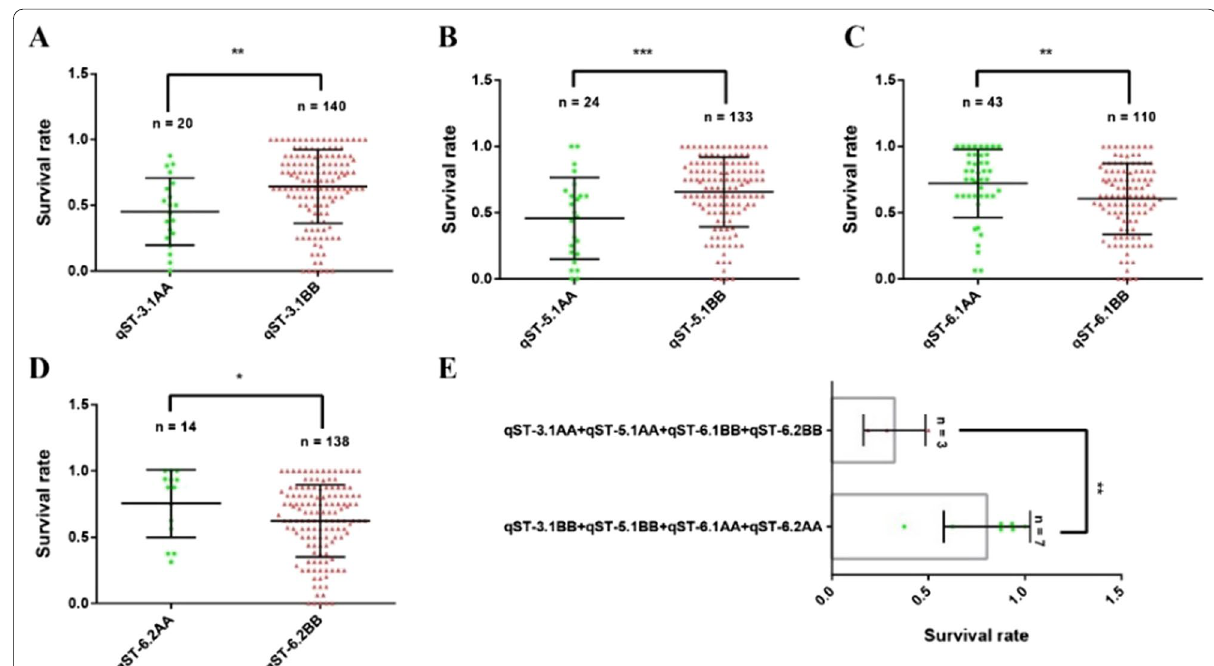
Fig. 4 The survival rate of rice seedlings with different genotyping of RILs. A. qST-3.1 ; B. qST-5.1 ; C. qST-6.1 ; D. qST-6.2 ; E. Aggregation of qST-3.1 , qST-5.1 , qST-6.1 , and qST-6.2 . Note AA means RPY geng and BB means Luohui